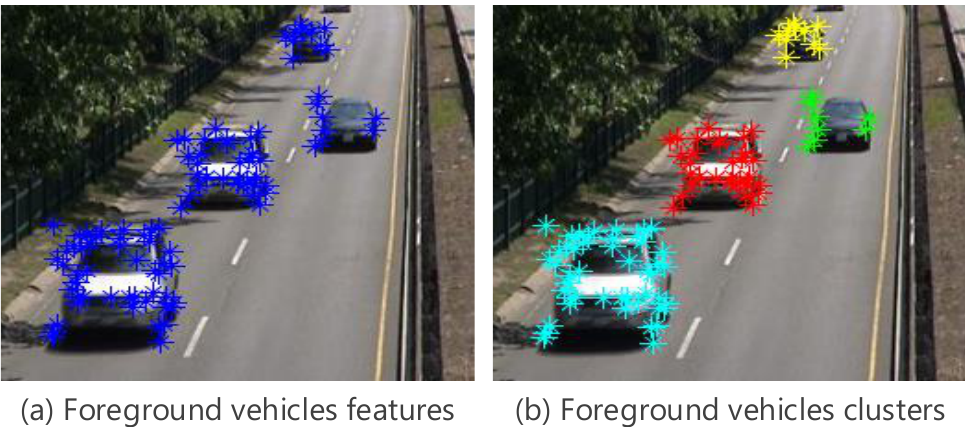
Figure 4. Clustering the foreground